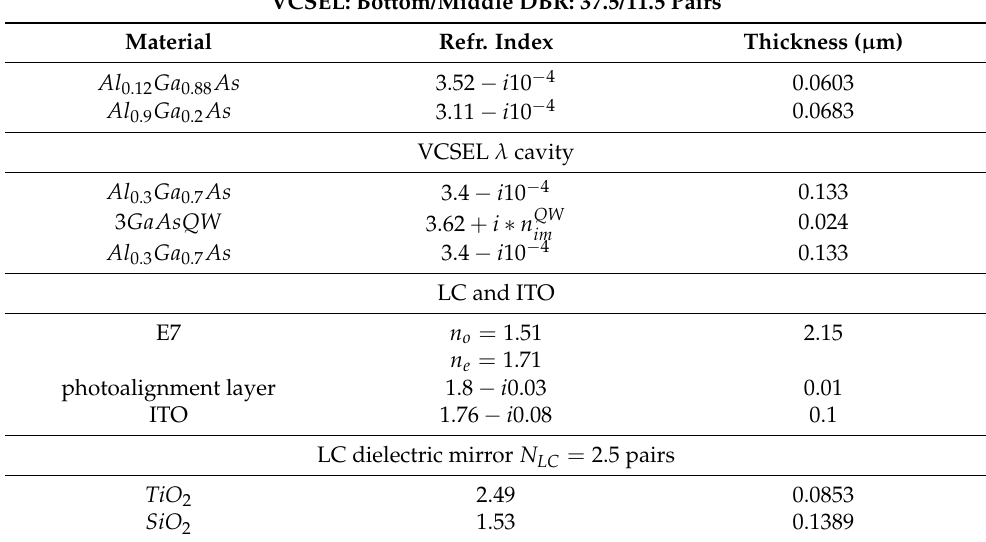
Table 1. VCSEL and LC parameters. VCSEL: Bottom/Middle DBR: 37.5/11.5